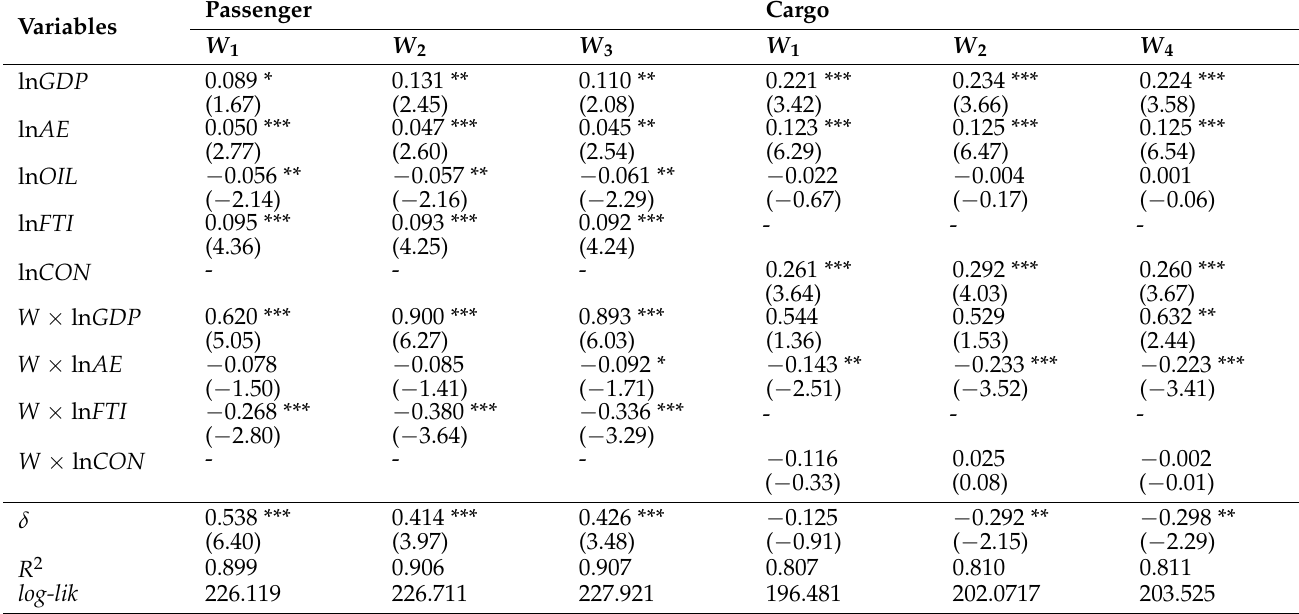
Table 4. Spatial regression results for the full data model with W 1 , W 2 , W 3 , and W 4